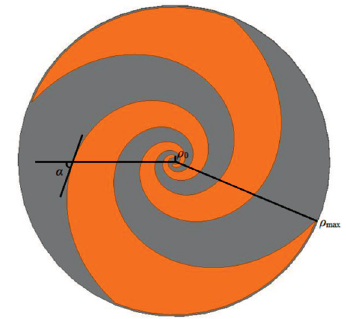
Figure 1. Geometry of a dual-arm ESA.